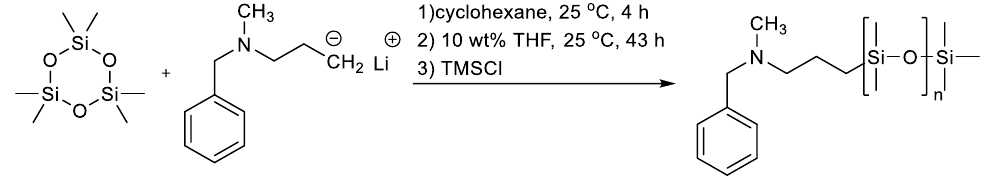
Figure 13. Anionic Polymerization of D 3 Using 3-[(N-Benzyl-N-methyl)amino]-1-propyllithium.